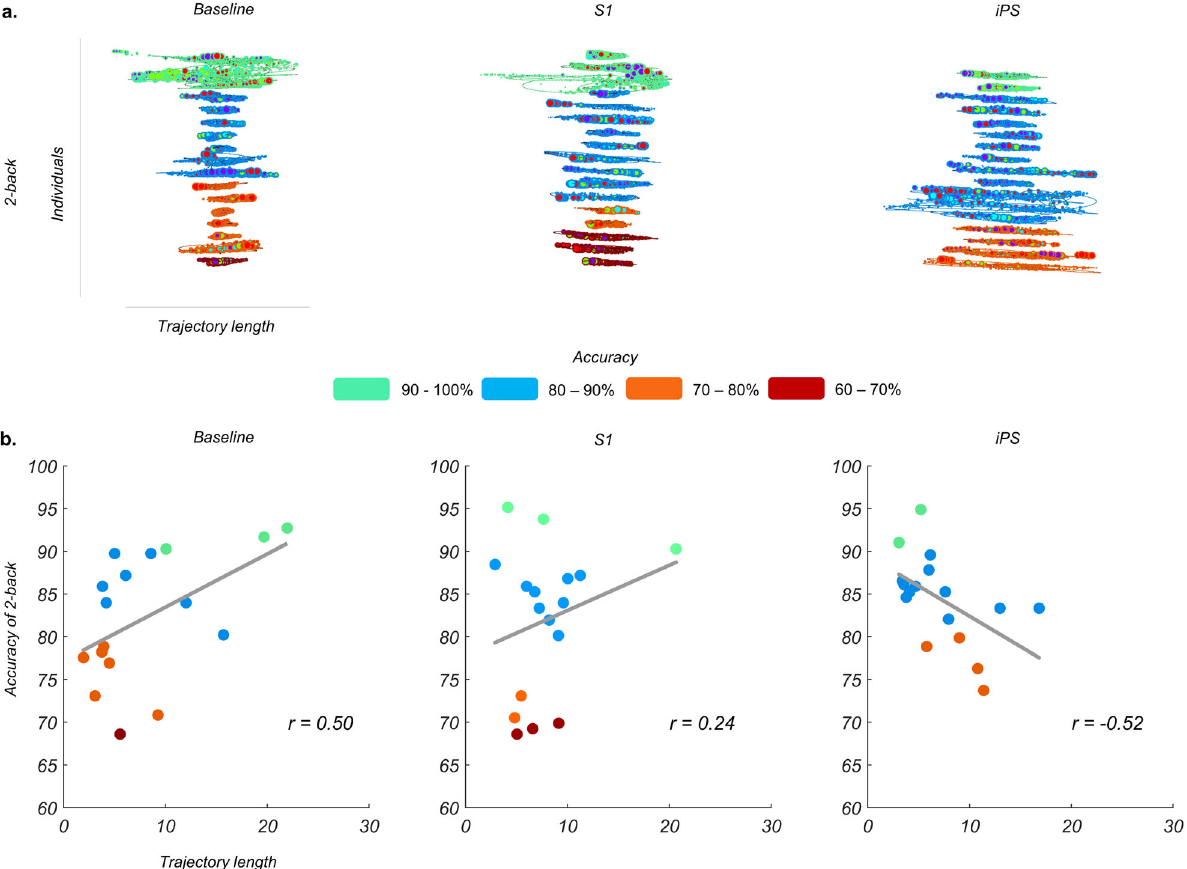
Fig. 3 Associations between individual low-dimensional trajectories of brain activity and working memory performance. a Analysis of the total length of low-dimensional trajectories for correct 2-back trials (measured across PHATE1, PHATE2, and PHATE3 dimensions) revealed a gradient linking individual trajectory length and behavioral accuracy across experimental sessions. Here each participant is tiered by overall task accuracy bands (% of correct 2-back trials). b Linear relationship between participants ’ trajectories and task accuracy for each session. In the baseline and the S1 session, longer trajectories link to higher 2-back accuracy whereas following perturbation of iPS, longer trajectories corresponded with lower task accuracy. Source data are provided as a Source data fi